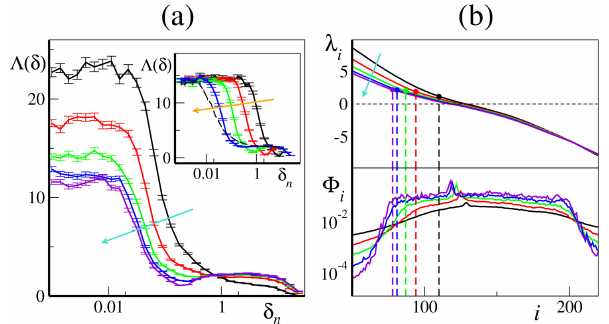
Figure 8. FSLE analysis. (a) FSLEs for different coupling con- stants, h = 1 (black line), h = 1 / 2 (red line), h = 1 / 4 (green line), h = 1 / 8 (blue line) and h = 1 / 16 (red line) – decreasing along the cyan arrow – vs. the finite-size amplitudes δ n for the γ = 10 − 3 norm. In the inset are the FSLEs for h = 1 / 4 and different γ norms ( γ = 1, 10 − 1 , 10 − 2 and 10 − 3 , decreasing along the orange arrow). The error bars measure one standard error. The black dashed line marks the FSLEs for the limiting case γ → 0. Note the logarithmic scale for the abscissa of both graphs. (b) Details of the LE spectrum (top part of panel) and of the (cid:56) i average projection norm patterns (bottom part of panel) as in Fig. 3b. The solid dots and the vertical dashed line mark the value and the location of the LEs λ i as iden- S tified in Table 2 (see main text for more details). Different coupling constant values are color-coded as in panel (a) , with h decreasing along the cyan arrow in the top part of the panel.